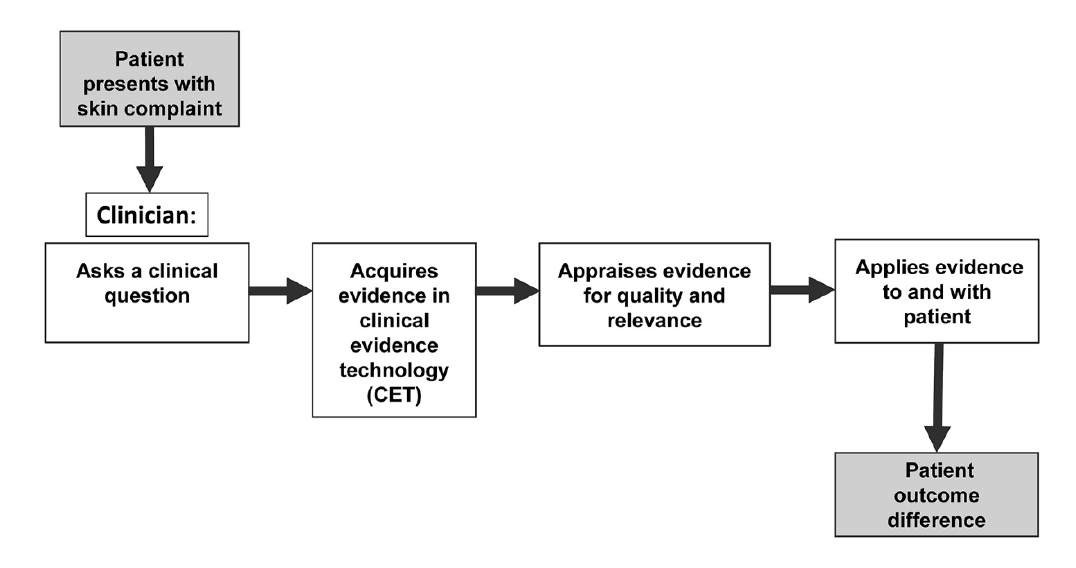
Figure 1 Behavioral steps model based on the evidence-based medicine (EBM)